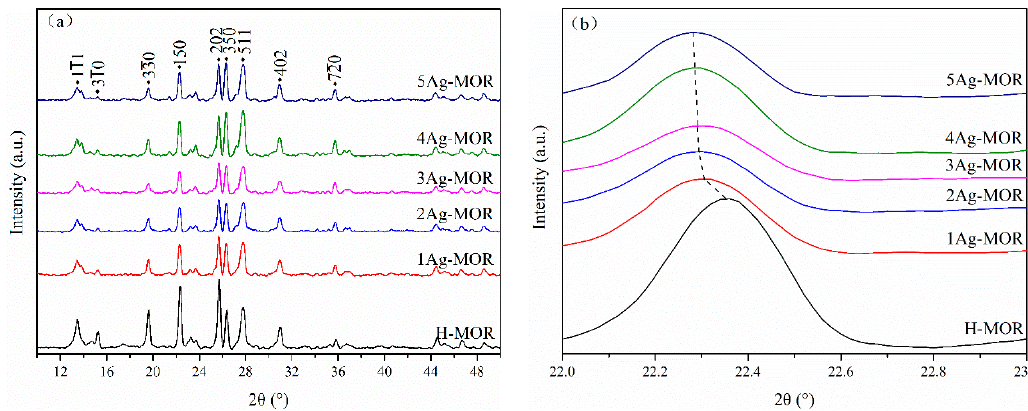
Figure 3. XRD patterns of samples. ( a ) Enlarged scale 2 θ = 10.0°–50.0°; ( b ) enlarged scale 2 θ = 22.0°–23.0°.